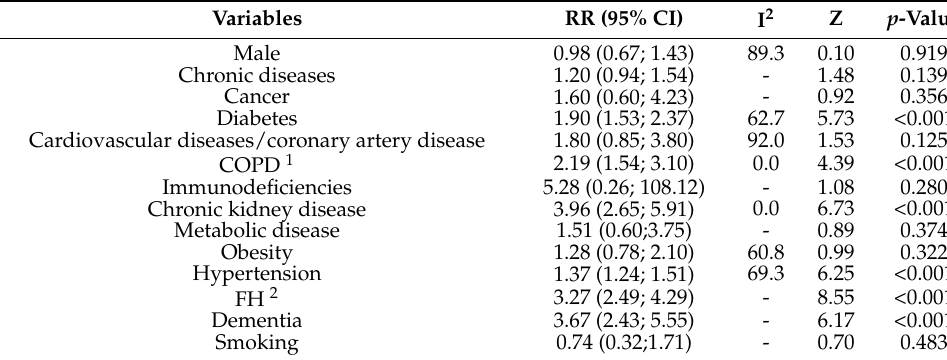
Table 5. Meta-analysis of factors associated (quantitative variables) with